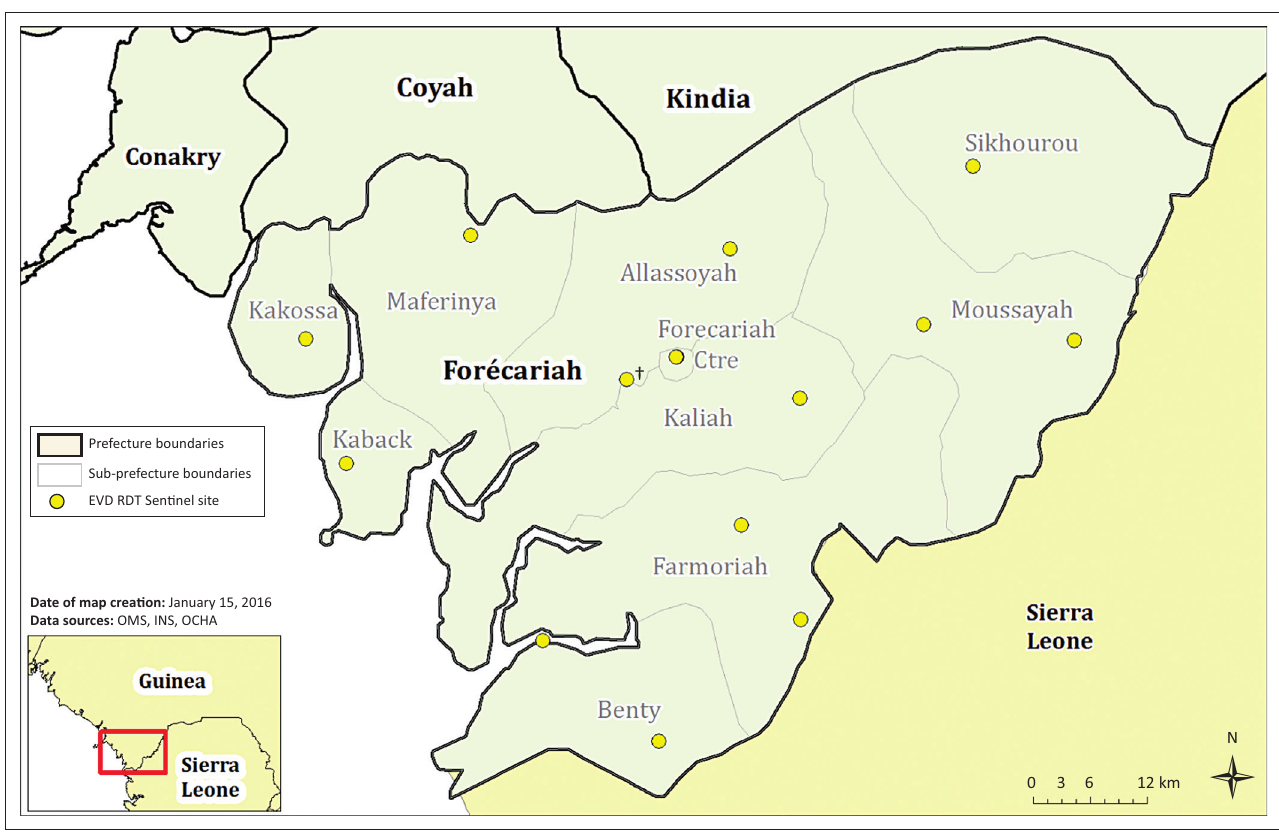
FIGURE 2: Map of health facilities selected for the OraQuick ® Ebola RDT pilot in Forécariah